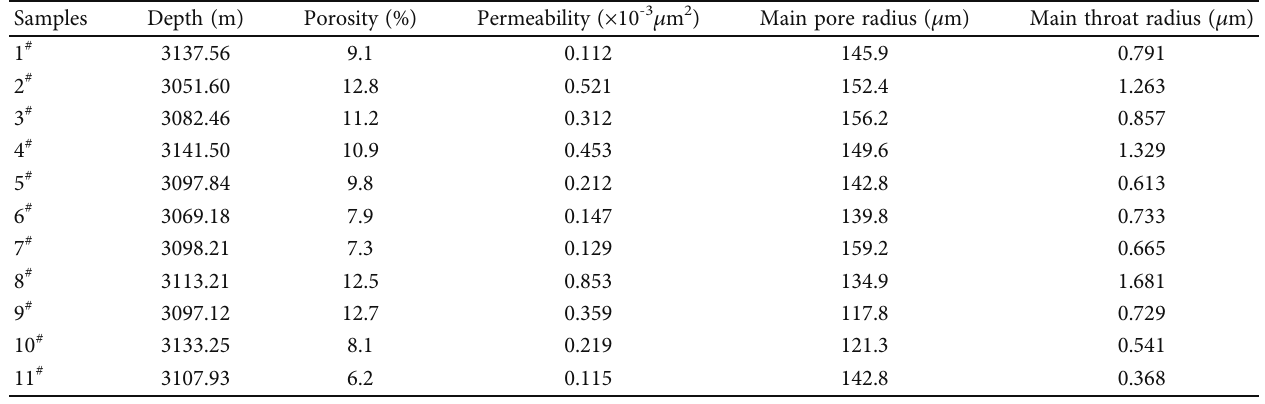
Figure 3: Diagram of nitrogen and water seepage experiment. (i) Air source, (ii) injection pump, (iii) adjusting valve, (iv) bu ff er bottle, (v) water bottle, (vi) nitrogen bottle, (vii) injection pressure gauge, (viii) sample, (ix) separator, (x) surrounding pressure gauge, and (xi) surrounding pump. Table 1: Porosity, permeability, pore, and throat of 11 samples.